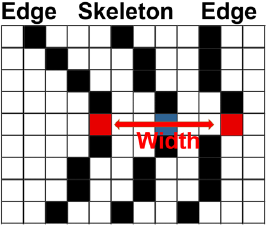
Figure 3. The widths of the crack along with the skeleton (in